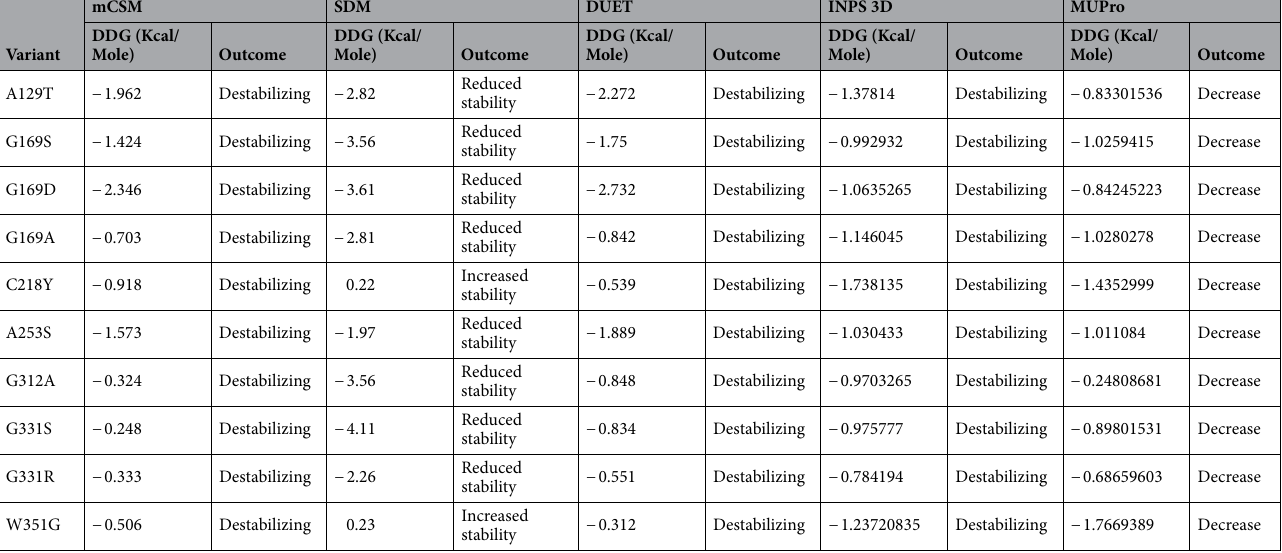
Table 2. Stability prediction of 10 prioritized nsSNPs of Wnt1. Stability was predicted as ΔΔG = ΔG (New Protein) − ΔG (Wild Type) in Kcal/mol.